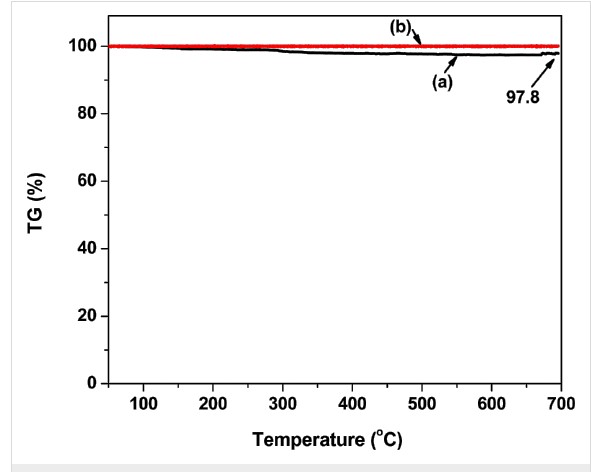
Figure 3: TGA of (a) ZrO 2 , and (b) Pt(1%)-ZrO 2 .